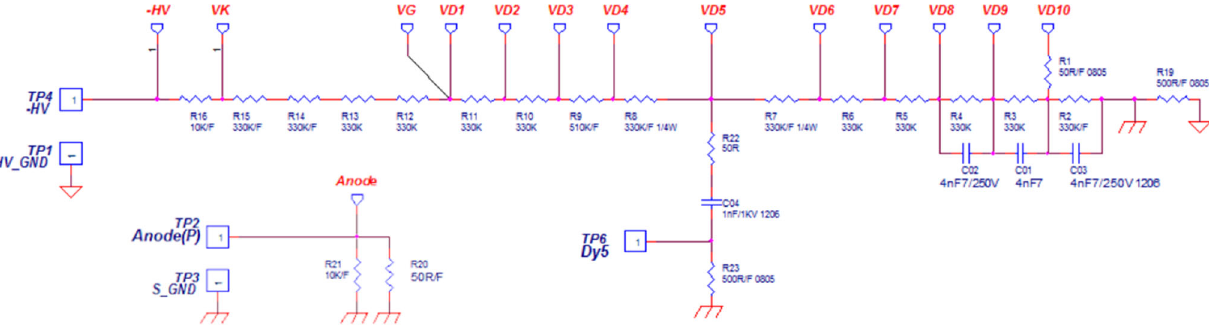
Fig. 11 Schematic of crystal PMT voltage divider